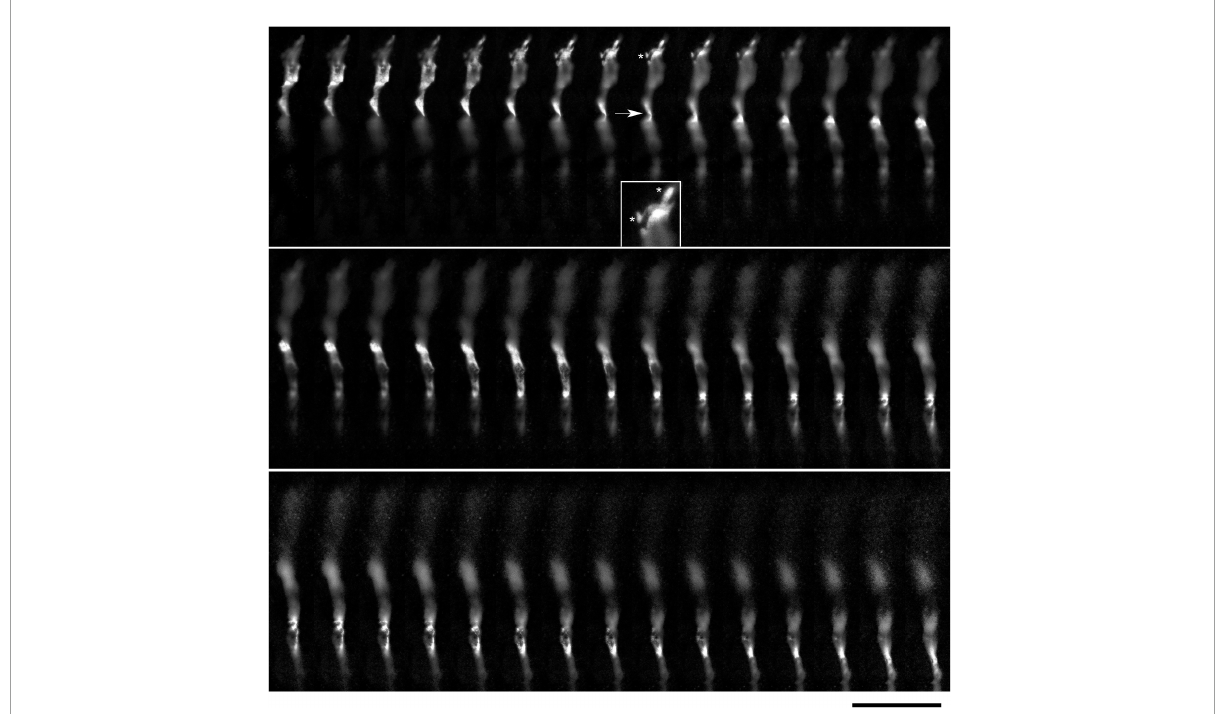
FIGURE9 A super-resolution microscopy (STED) z-series of a single serotonergic (5-HT +) axon in the sectioned cortical plate of a mouse embryo at E17. Note the growth cone protrusions similar to those in culture (e.g., Figure 3B ; asterisks, inset) and a potentially flat membrane region (arrow, further analyzed in Figure 10 ). The sequential optical sections are evenly separated by 100 µ m. Scale bar = 20 µ m.